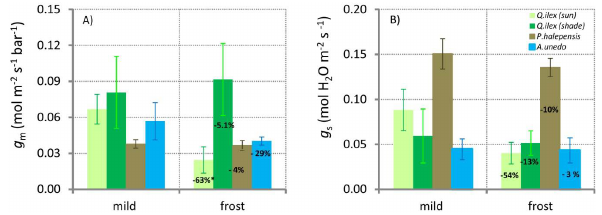
Figure 3. Bar plot of the effect of a sudden period of frost following a mild winter period on (a) nighttime respiration ( R n ) and (b) day- time respiration ( R d ) in sunlit leaves of Q. ilex (light green bar), in shaded leaves of Q. ilex (dark green bar), P. halepensis (beige bar) and A. unedo (blue bar). The error bars represent the standard er- ror, and the percentages indicate the change between periods where significance is indicated with an asterisk ( P ≤ 0 . 05).